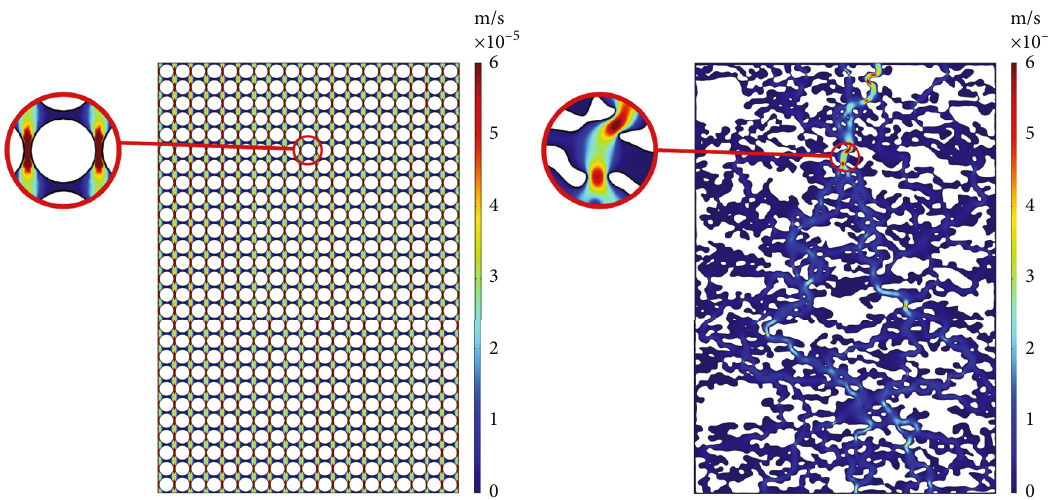
Figure 6: Steady-state fl ow fi eld of the NMRI model and uniform